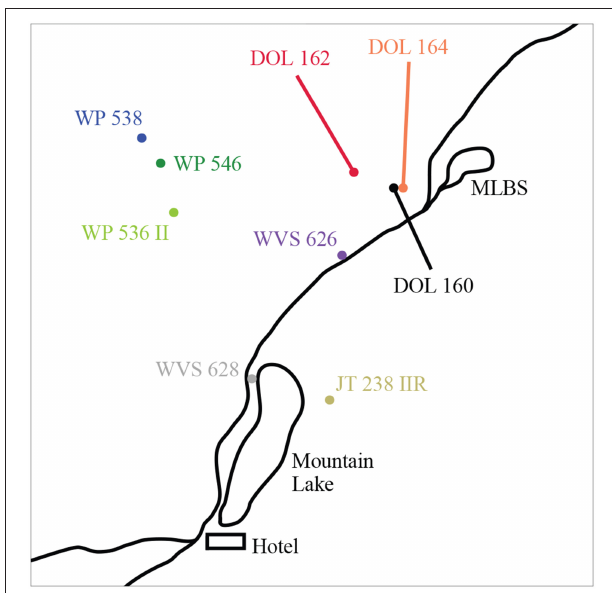
FIGURE 1 | Relative locations of the nine dark-eyed junco nests simultaneously sampled at Mountain Lake Biological Station (MLBS), Virginia. The nest-specific color-coding persists in figures throughout the paper, as